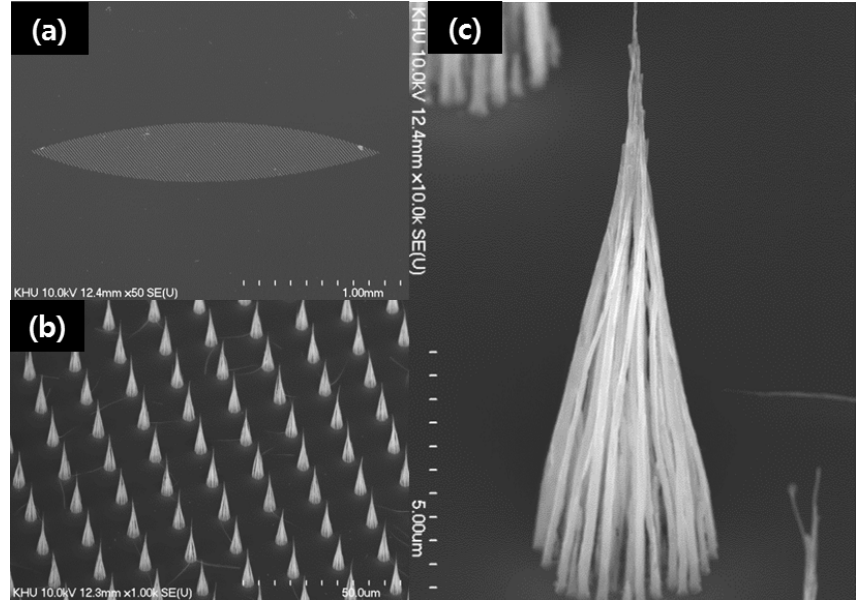
Figure 3. SEM images of the ( a ) elliptical emitter with 2.0 mm × 0.5 mm formed by RAP process; ( b ) magnified image of CNT array emitters with 3 µm islands and 15 µm pitch; ( c ) a magnified image of one